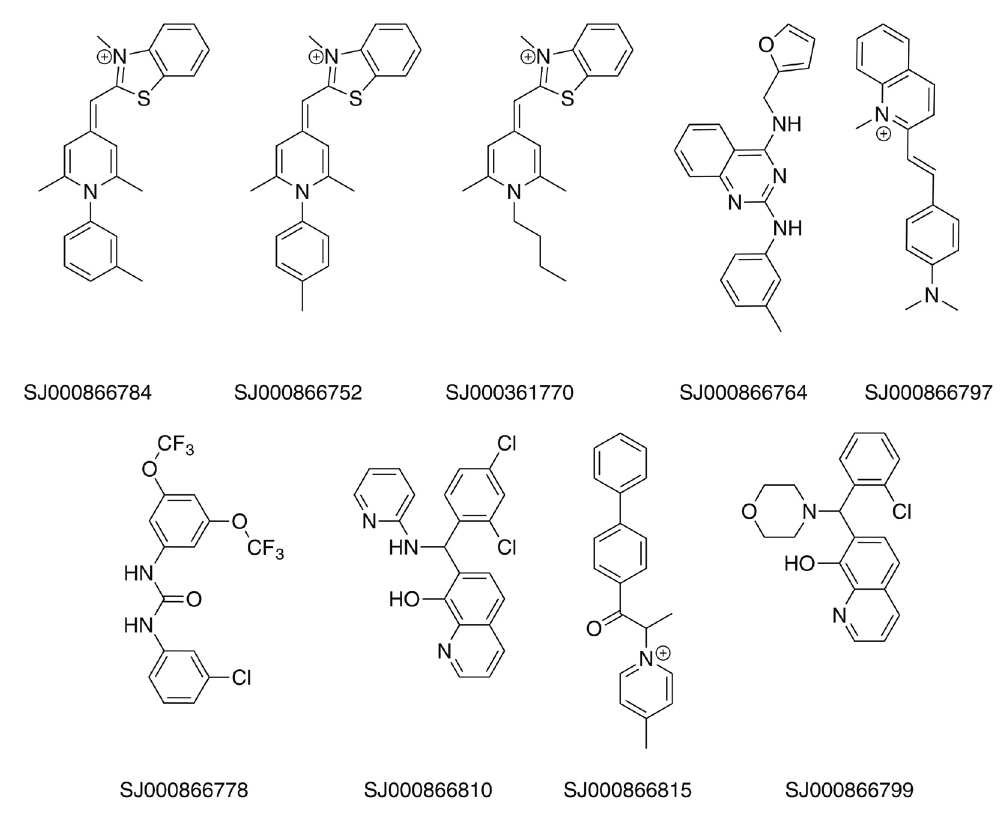
Figure 5. Nine compounds proposed by Workflow 2. The molecules are ordered by decreasing activity.